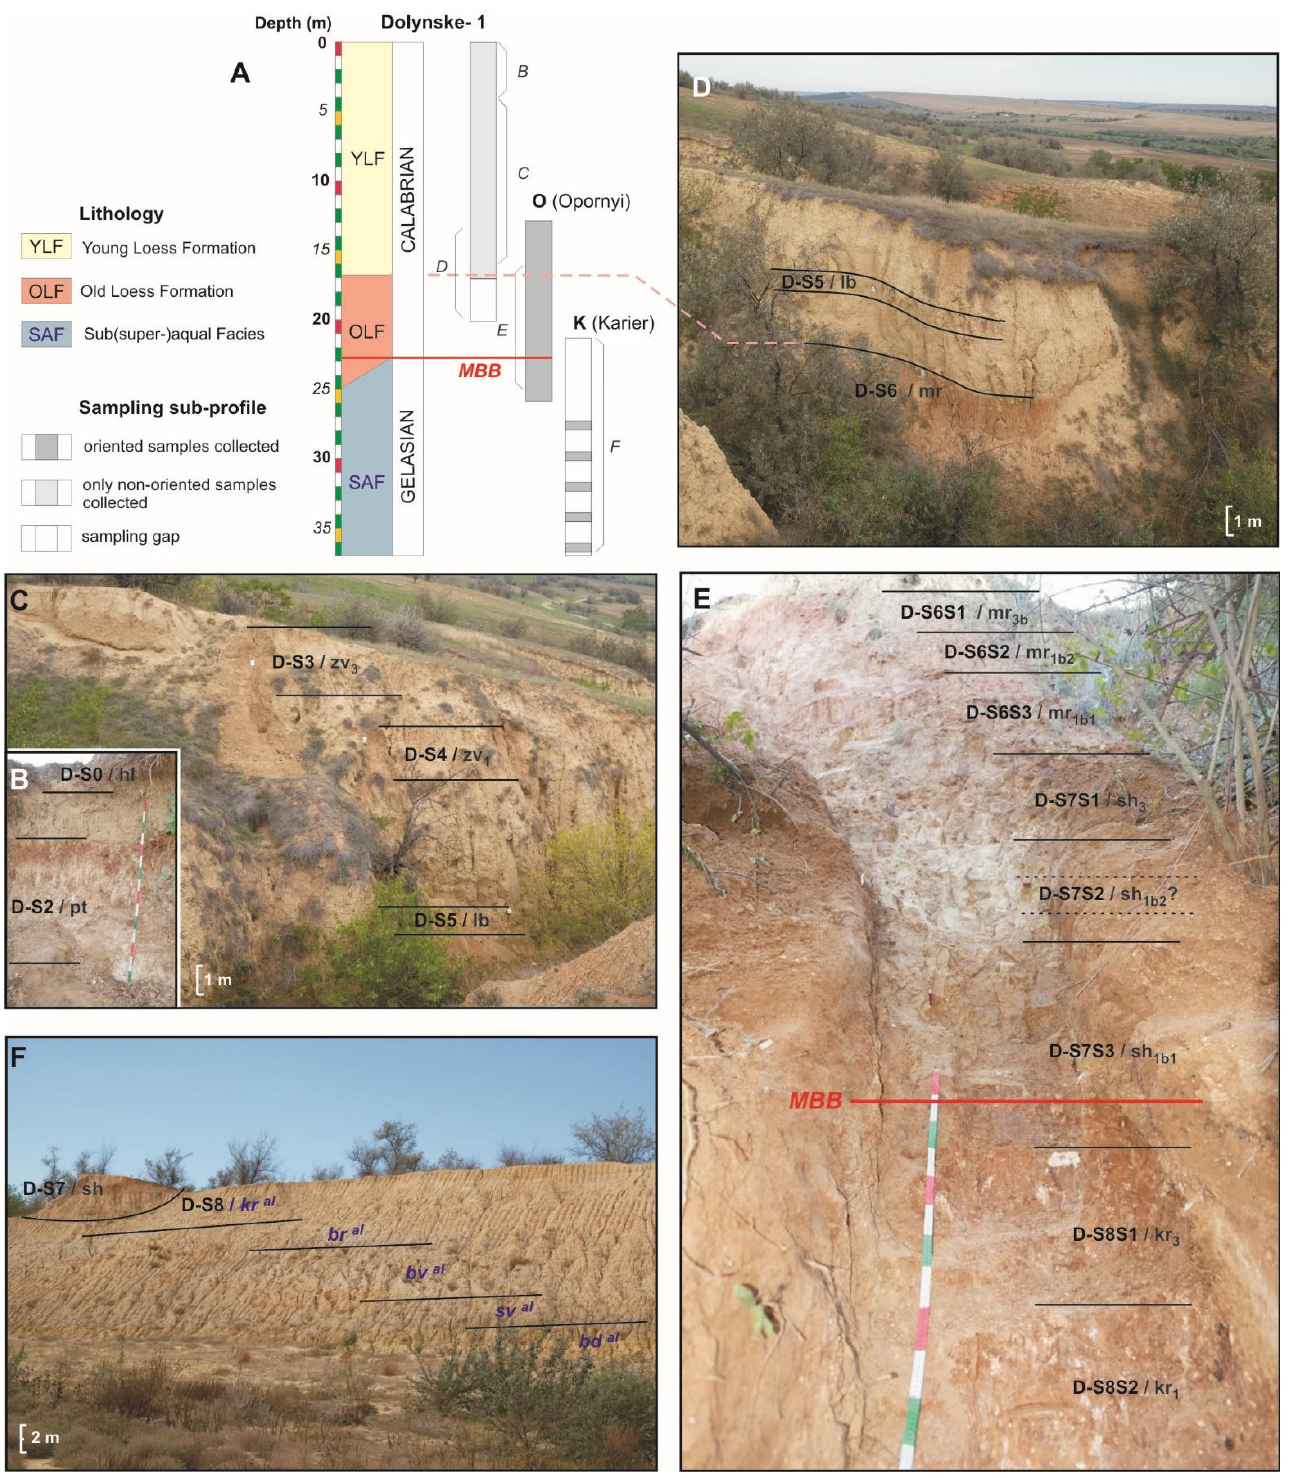
Figure 2. ( A ) Simplified geological section and sampling intervals of the named exposures (subprofiles) at the Dolynske site, accompanied by field photographs of ( B ) uppermost, ( C ) upper middle, ( D ) lower middle and ( E ) lowermost loess – palaeosol units and ( F ) alluvial deposits. For lithopedological description, see Section 3.1. The red line indicates the position of the detected Matuyama – Brunhes boundary (see Section 3.5).